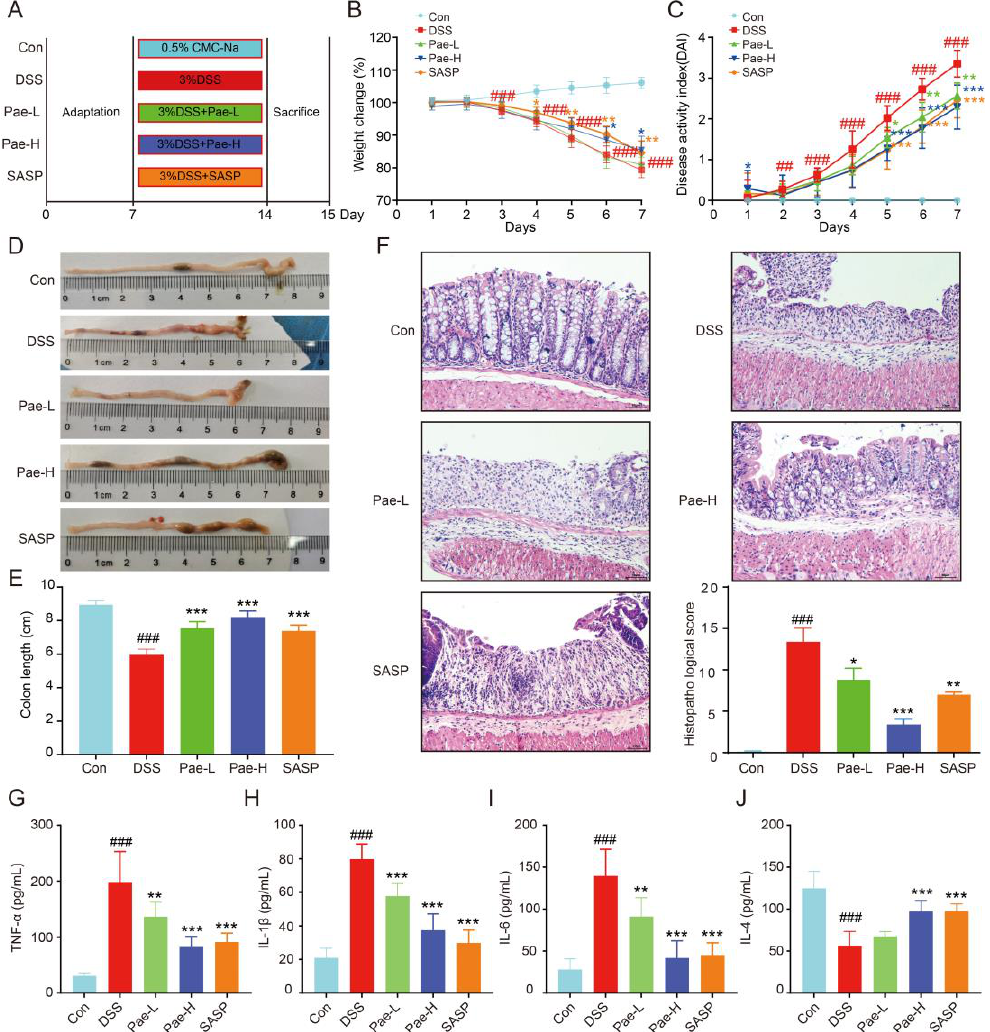
Figure 2. Pae attenuates the effect of DSS-induced UC in mice. ( A ) Experimental design. ( B ) Changes in body weight ( n = 8). ( C ) Disease activity index (DAI) scores ( n = 8). ( D and E ) Images of colon samples and changes in colon length (n = 7 or 8). ( F ) Representative images of hematoxylin and eosin ( H and E )-stained colon tissue and the scores of H and E , scale bar = 200 µm, ( n = 5). ( G - J ) Expression levels of TNF- α ( G ) IL-1 β ( H ), IL-6 ( I ) and IL-4 were detected by enzyme-linked immunosorbent assay (ELISA) ( n = 6-8). Data are shown as mean ± sem. # p < 0.5; ## p < 0.01; ### p < 0.001, compared with Con group, * p < 0.5; ** p < 0.01; *** p < 0.001, compared with DSS group.